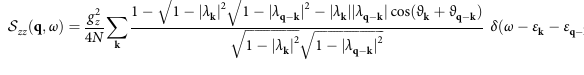
ffiffiffiffiffiffiffiffiffiffiffiffiffiffiffiffiffiffiffiffiffiffi 1 (cid:3)j λ q (cid:3) k j 2